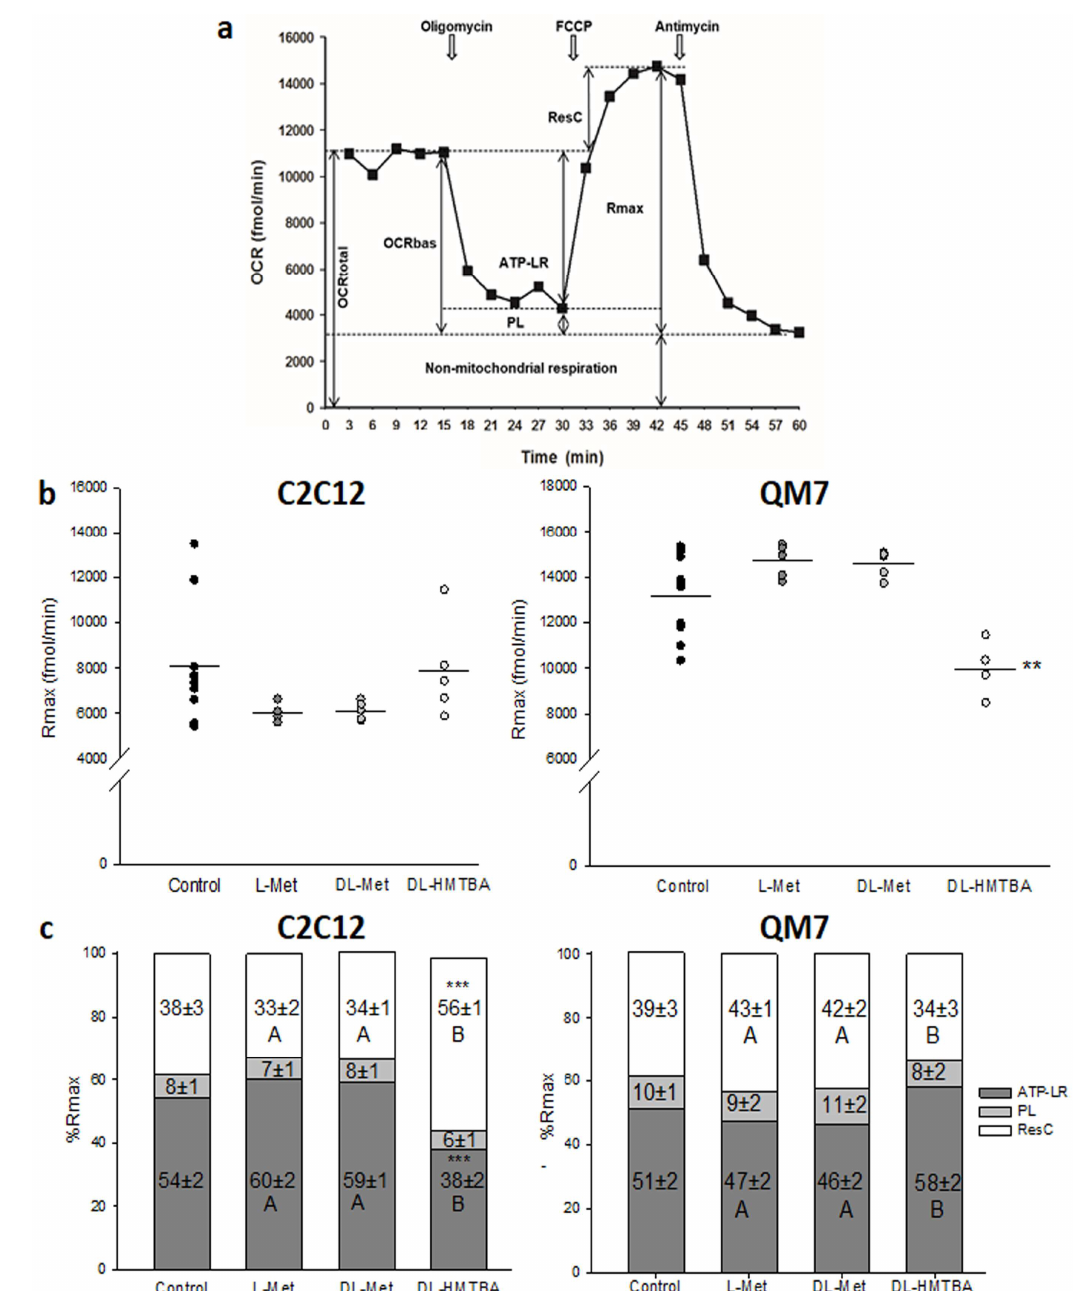
Figure 7. Measurement of bioenergetic parameters in C2C12 and QM7 cells after supplementation with 1000 µM of L-Met, DL-Met, or DL-HMTBA. ( a ) Schematic view of oxygen consumption rates (OCRs) measured under basal conditions (OCRbas) and in response to indicated mitochondrial inhibitors. The arrows show the sequential injection of oligomycin, FCCP, and antimycin A1 (10 µM each). Parameters calculated are also shown. ATP synthase-linked respiration (ATP-LR) and the respiration rate attributable to proton leak (PL) were calculated using OCRbas and oligomycin-in- sensitive respiration. FCCP uncoupled oxidative phosphorylation and disrupted the electrochemi- cal gradient (proton motif force; Δψm). It was employed to determine the maximal OCR (Rmax) of the cells. The injection of antimycin A1, a complex III inhibitor, allowed for the measurement of nonmitochondrial oxygen consumption by shutting down mitochondrial respiration. The mito- chondrial reserve capacity (ResC) was calculated as the difference between the Rmax and OCRbas. The total OCR was the sum of the OCRbas and the nonmitochondrial respiration. ( b , c ) Total values of Rmax ( b ) and proportions ( c ) of ATP-linked respiration (ATP-LR), proton leak (PL), and reserve capacity (ResC) on maximum FCCP-induced oxygen consumption rate (Rmax = 100%; c ) in C2C12 and QM7 cells treated with 1000 µM of L-Met, DL-Met, or DL-HMTBA. Unstimulated cells served as controls. DL-HMBTA significantly reduced the Rmax in QM7 cells. In C2C12 cells, no significant changes in the Rmax were induced by methionine. Nevertheless, the proportional composition of the Rmax was significantly altered by supplementation with 1000 µM of DL-HMTBA in C2C12 cells,